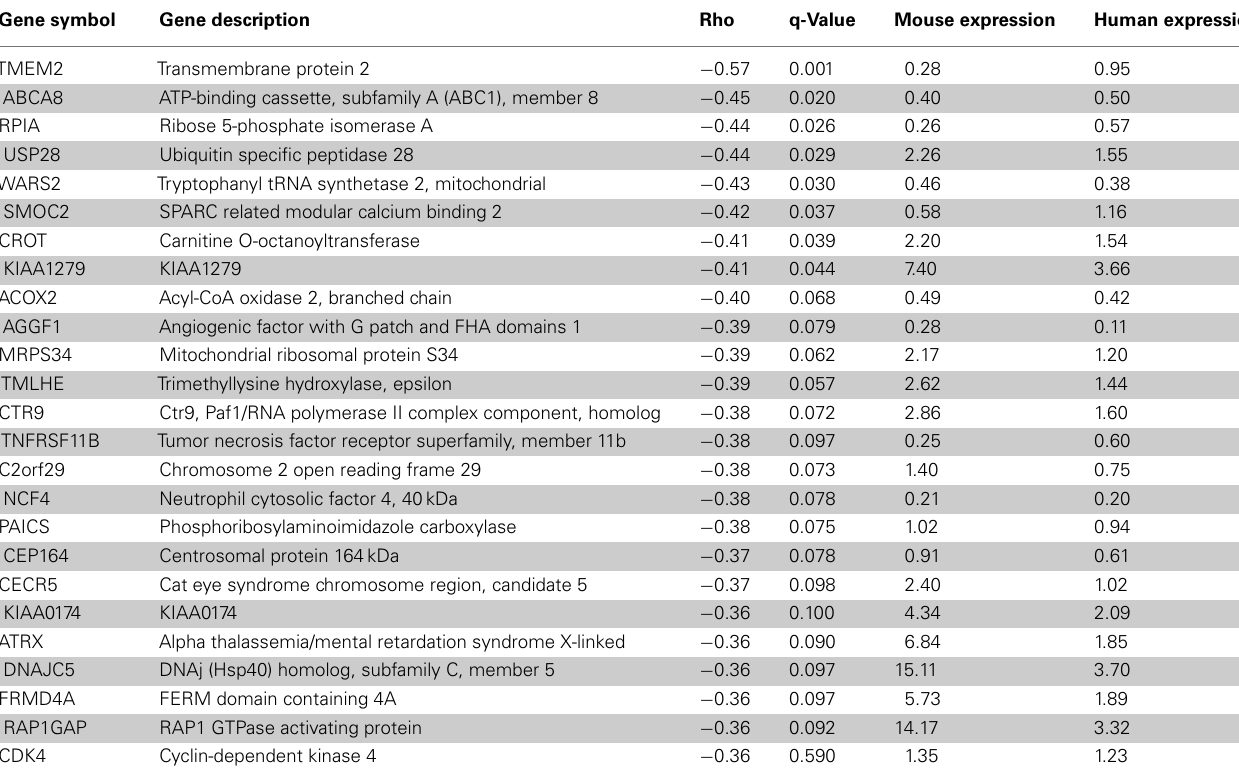
Table 5 |Top 25 genes with anti-correlated expression patterns between mouse (Mouse expression) and human H0351.2001 (Human expression) sorted by Spearman rank correlation